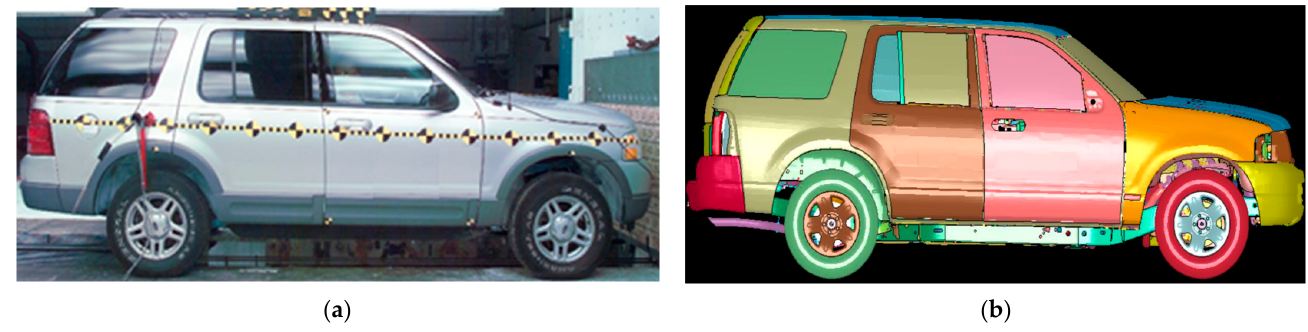
Figure 1. Comparison of virtual SUV model and real SUV model: ( a ) Real model of a 2002 Ford Explorer SUV XLT 4WD [23]; ( b ) virtual model of the same SUV Ford Explorer 2002 XLT 4WD.